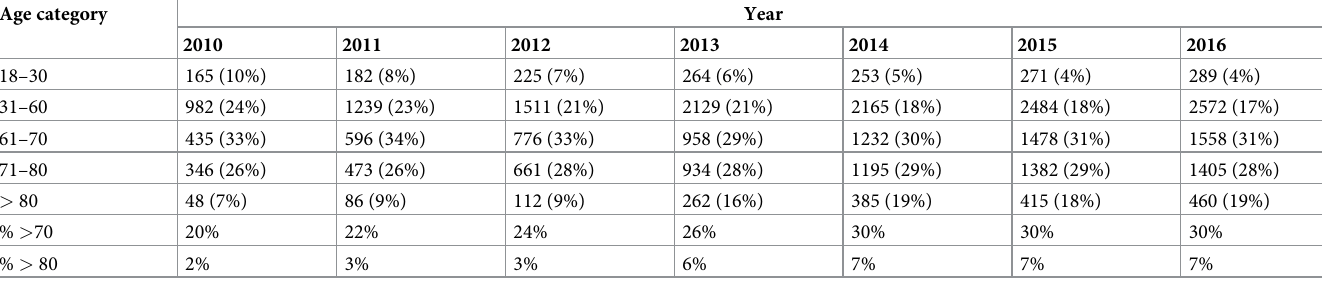
Table 4. Number of ECMO cases and age category.